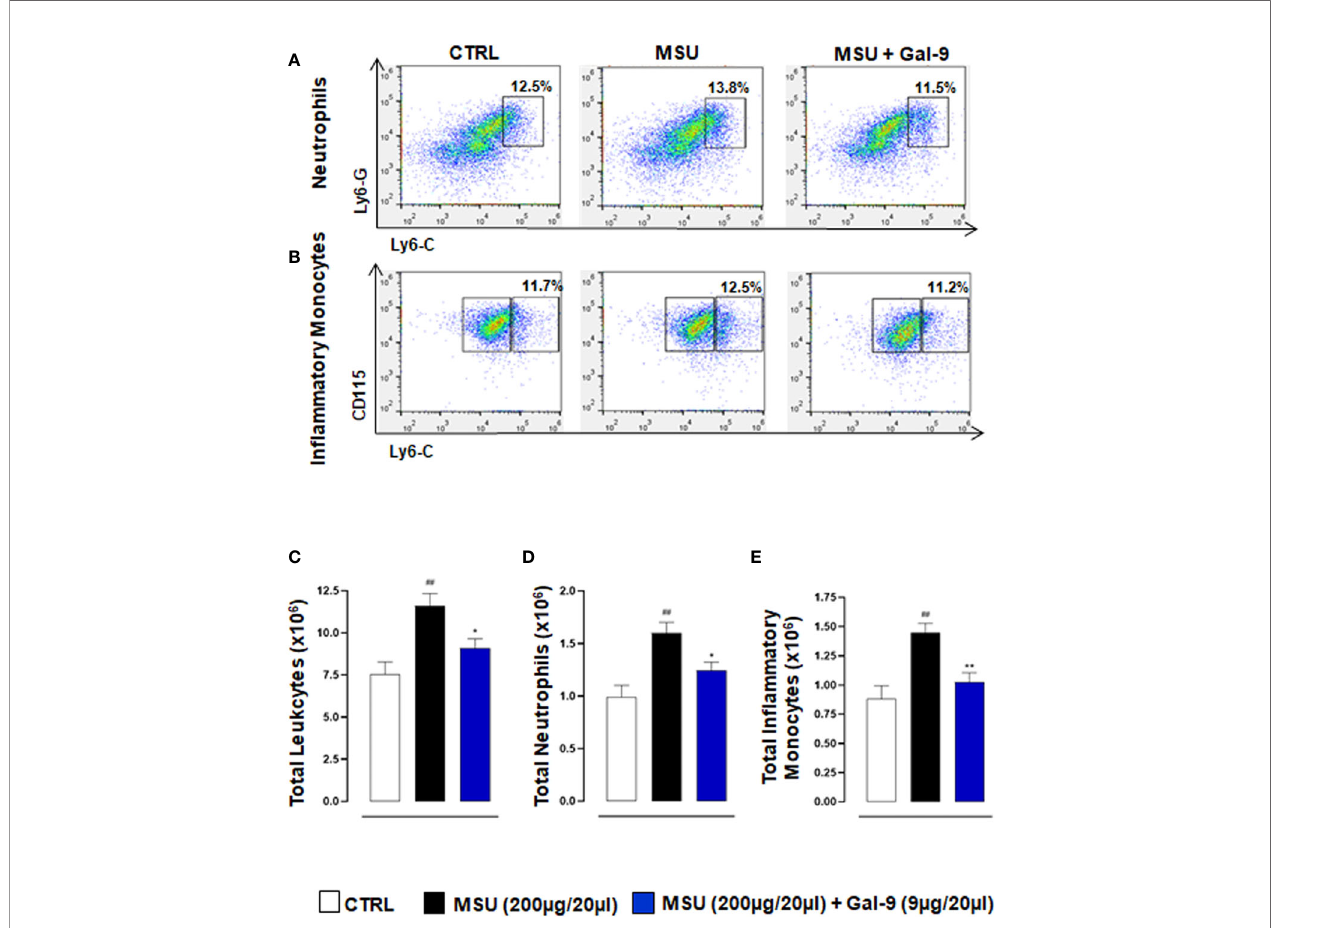
FIGURE 2 | Gal-9 modulates the recruitment of innate immune cells. Flow cytometry analysis was employed to determine in situ neutrophil and monocyte subsets. At the peak of in fl ammatory reaction (18h), ankle joints were digested, and single cell suspensions were obtained. Flow cytometry strategy applied to identify neutrophils (A) , and monocytes (B) , after Gal-9 treatment are shown. Cells were washed and stained with: CD45, LY6-C, LY6-G, CD11b, and CD115/CD45 + cells were plotted for LY6-C and LY6-G expression to identify CD45 + /LY6-C hi /LY6-G hi as neutrophils (A) . CD11b + cells were plotted for LY6-C and CD115 expression to distinguish CD11b + /CD115 + /LY6-C lo patrolling monocytes from CD11b + /CD115 + /LY6-C hi in fl ammatory monocytes (B) . (C) Total in fi ltrated leukocytes, (D) neutrophil and (E) in fl ammatory monocytes were quanti fi ed in the different experimental conditions. Representative FACS plots of three independent experiments with similar results are shown. Values are presented as means ± SEM of n = 6 mice per group. Statistical analysis was conducted by one-way ANOVA followed by Bonferroni ’ s for multiple comparisons. ## P ≤ 0.01 vs Ctrl group; *P ≤ 0.05, **P ≤ 0.01 vs MSU